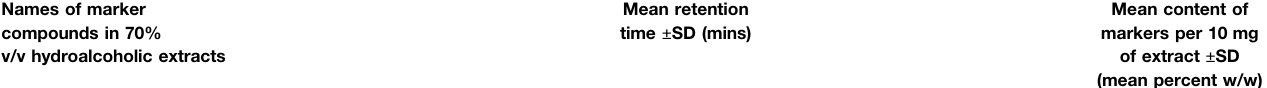
TABLE 3 | Content of diosgenin, charantin, and hydroxychalcone in the 70% v/v ethanolic extracts of T foenum-graecum , M charantia , and C zeylanicum , respectively. Names of marker compounds in 70% v/v hydroalcoholic